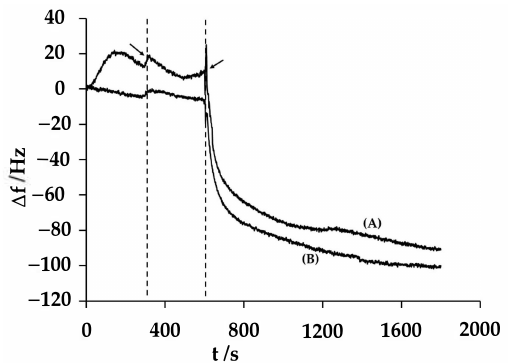
Figure 4. Frequency shifts ( ∆ f) recorded during the addition of 1 mL of the 1 M H 2 SO 4 solution at 5 min and 1 mL of the PSS solution at 10 min, equivalent to a final concentration of polyelectrolyte of (A) 20 and (B) 40 mM in 1 M H 2 SO 4